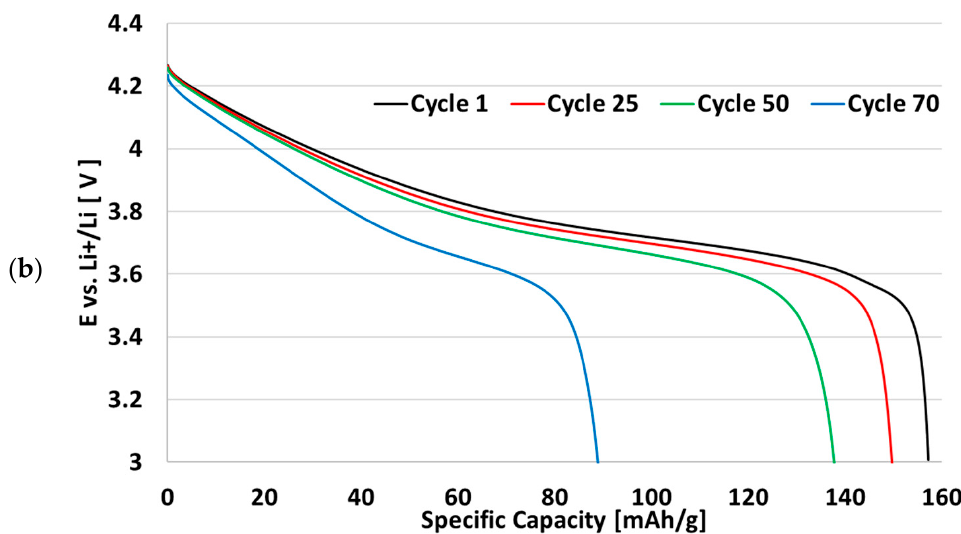
Figure 12. Discharge of cathode half-cells with C-rates of ( a ) C/5, and ( b ) C/10.